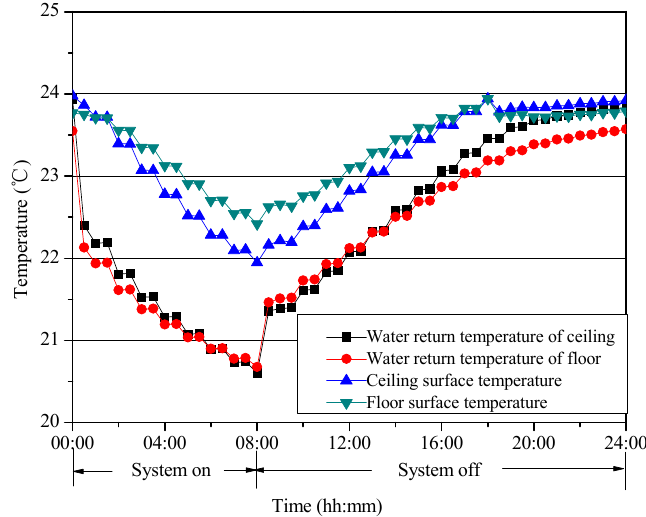
Figure 4. Cooling surface temperature and water return temperature variation trends on 10 July.